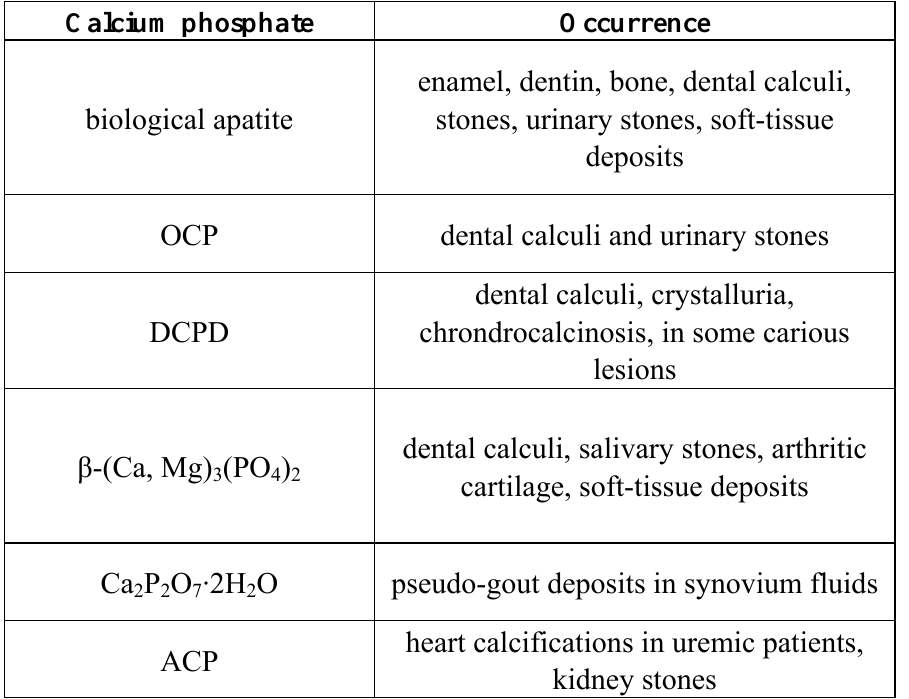
Table 4. Occurrence of various calcium phosphates in biological systems (human)